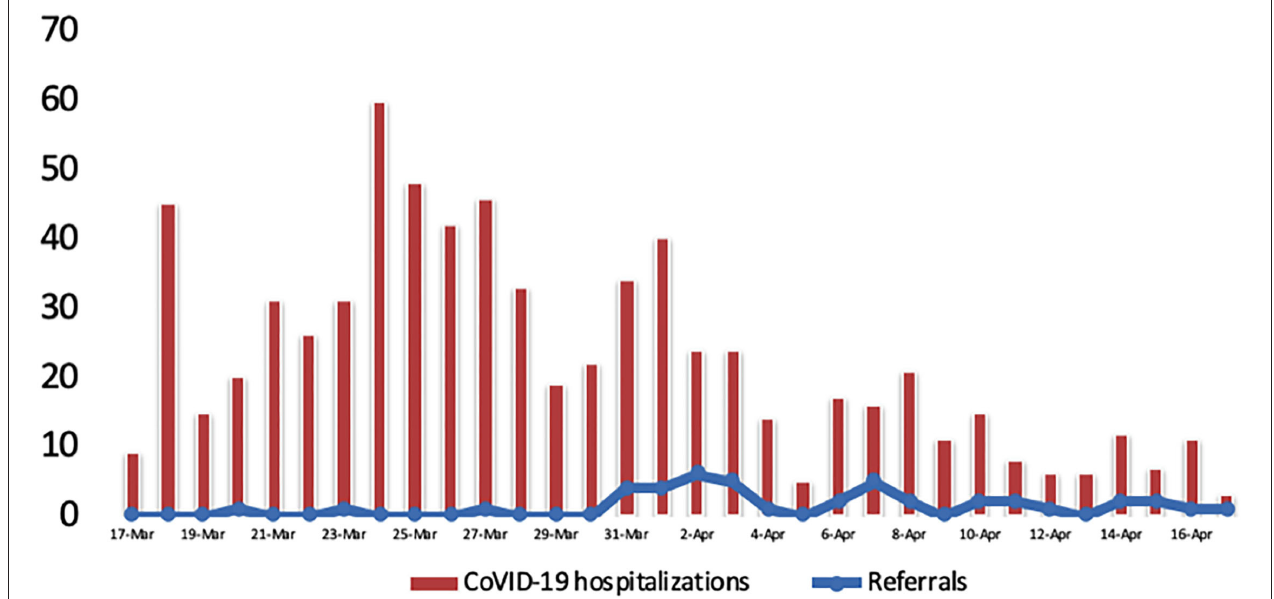
Frontiers in Psychiatry |